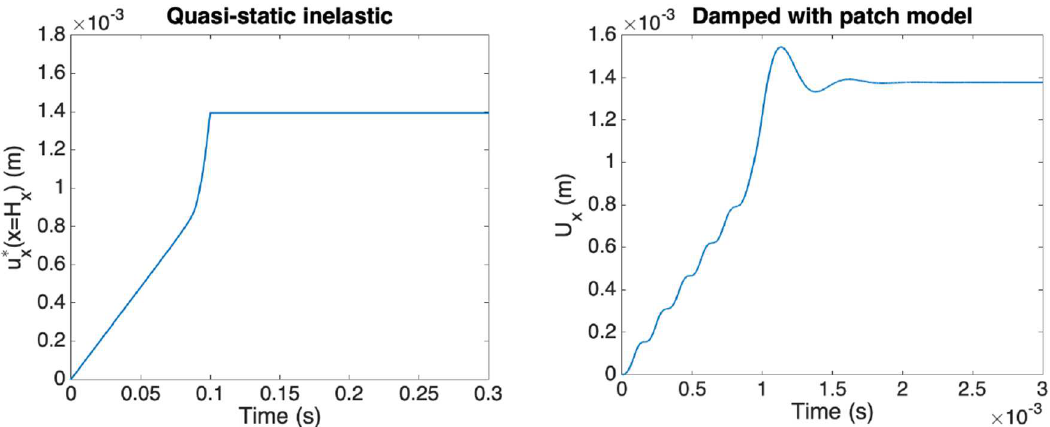
Fig. 23. Quasi-static solution given in Figure 18 (left) versus the explicit damped obtained using the global-local integration (right).